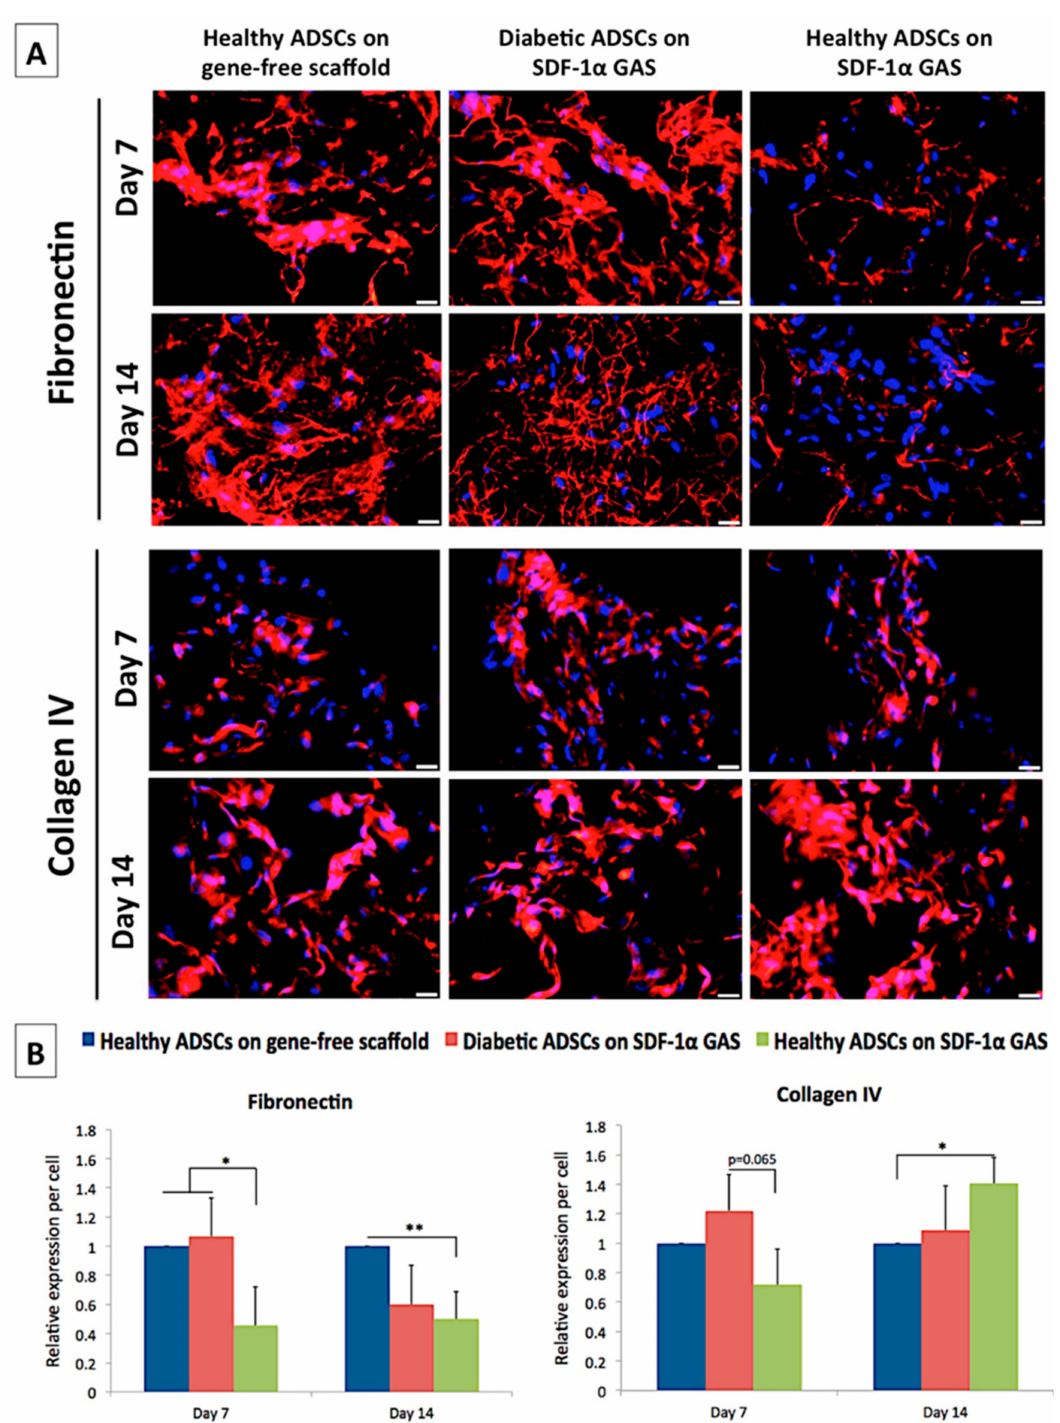
Figure 6. Effect of SDF-1 α gene-activated scaffold on the deposition and remodeling of pro-wound healing matrix proteins in healthy and diabetic ADSCs. ( A ) Relative to the healthy ADSCs on the gene-free scaffold, diabetic ADSCs on the SDF-1 α gene-activated scaffold showed a significant decrease in the deposition of fibronectin matrix while increasing the deposition of collagen IV over time. Contrarily, healthy ADSCs on the SDF-1 α gene-activated scaffold deposited minimal amounts of the fibronectin matrix throughout the culture period but significantly increased the deposition of collagen IV. ( B ) Semi- quantitative interpretation of spatiotemporal expression of the matrix proteins. * and ** indicate statistical significance at p < 0.05 and p < 0.01, respectively. Data are presented as mean ± standard deviation ( n = 3). Scale bar 20 µ